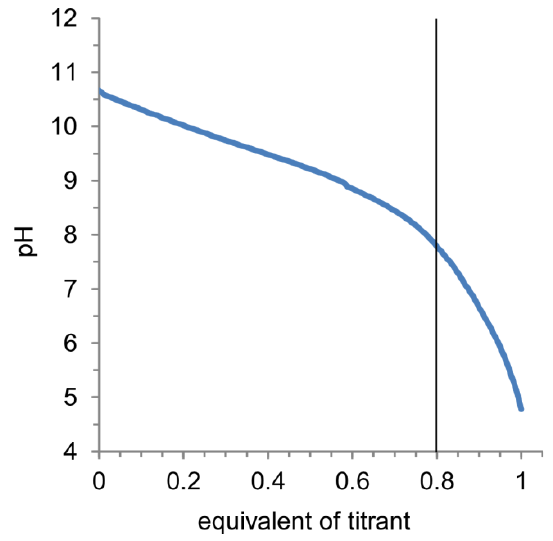
Figure 4. Acid-base titration curve of disulfide-bonded PAMAM dendron-PLL